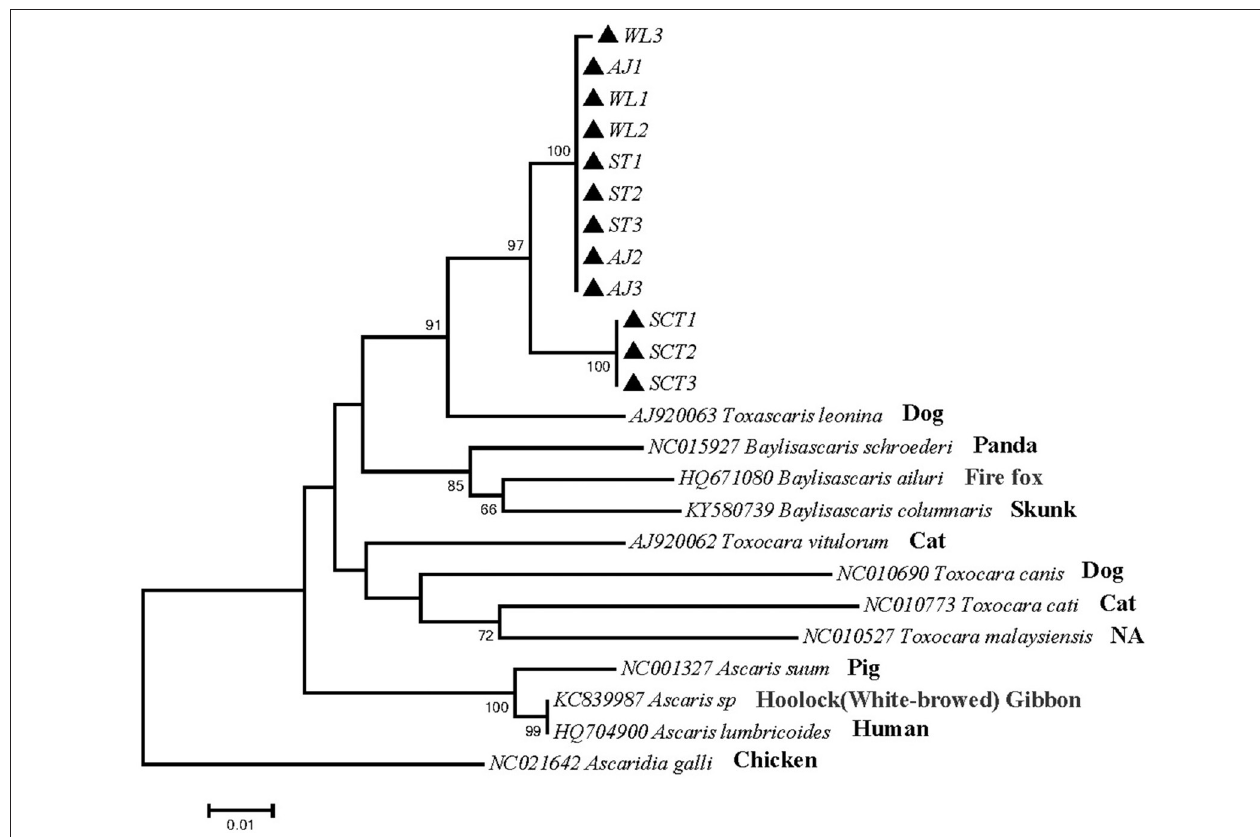
FIGURE 1 | Neighbor-Joining estimatesof the phylogenetic relationships of ascarids based on p cox 1 gene computed in MEGA version 7.0 under the Kimura 2-parameter model; The confidence levels in each node were assessed with the bootstrap method (1,000 pseudoreplicates) and bootstrap values > 50; The genotypes identified in this study are indicated by filled